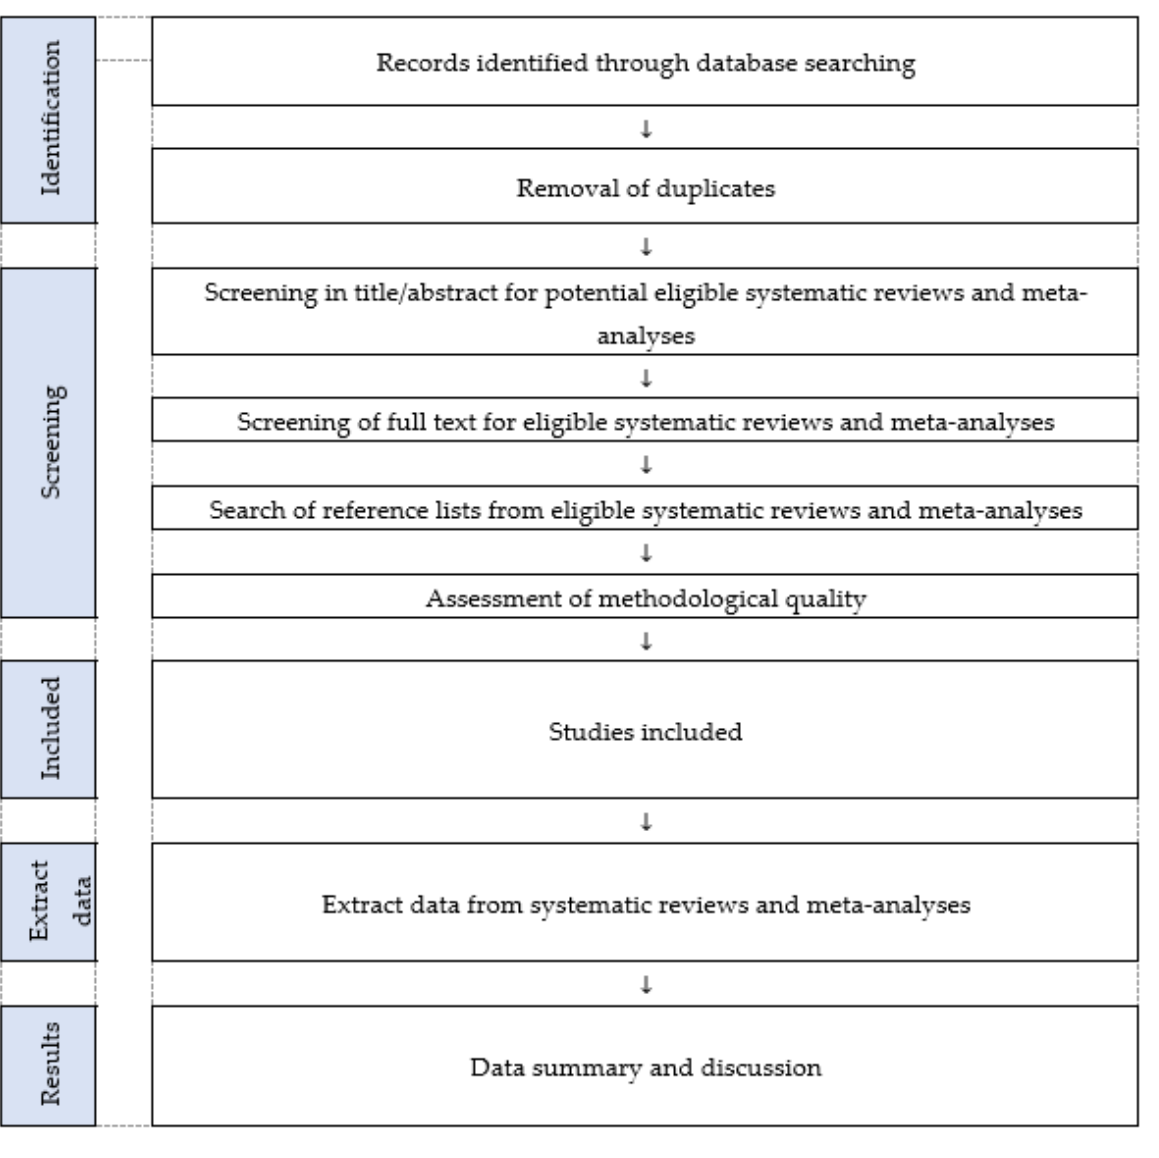
Figure 1. Flowchart of the umbrella review.